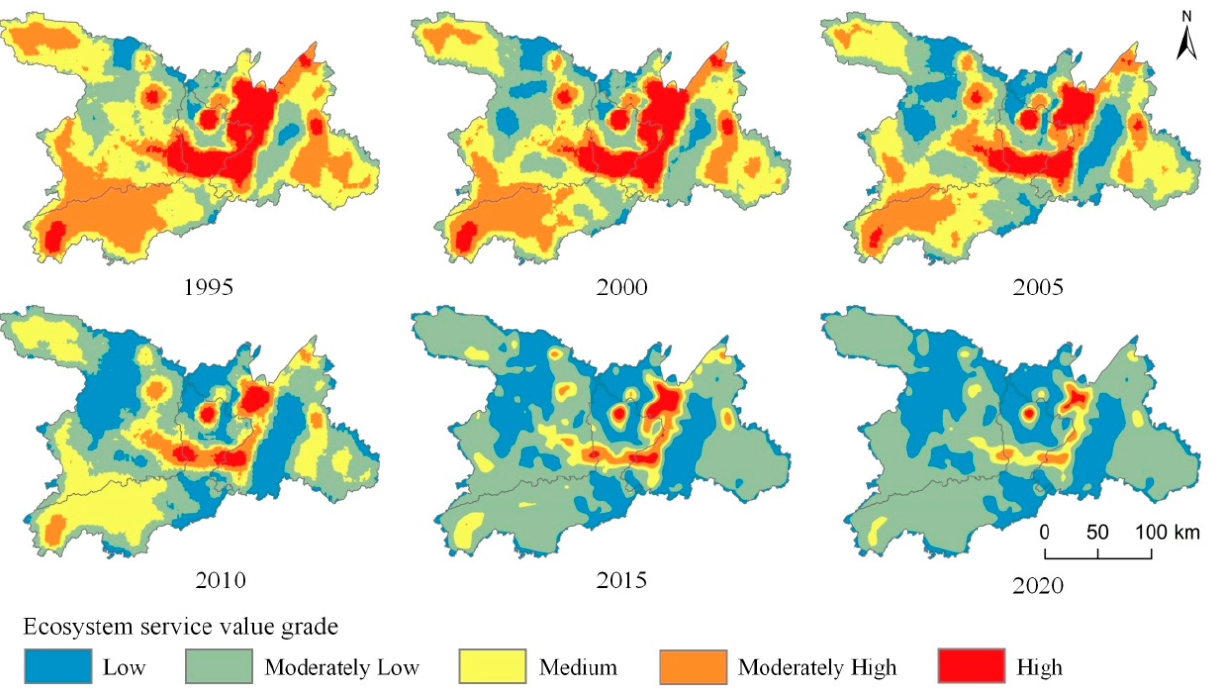
Figure 2. Spatial pattern of ecosystem service value per unit area in the Dongting Lake area from 1995 to